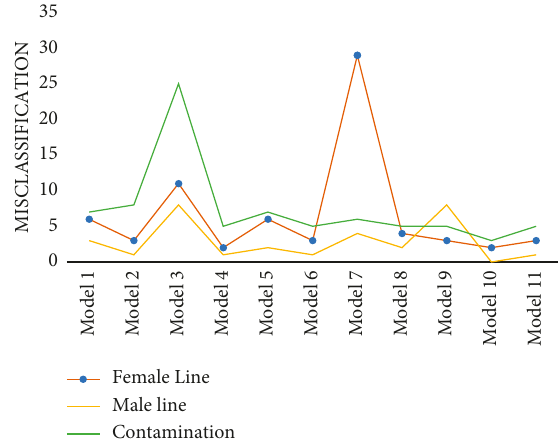
Figure 10: Plot of misclassification instances associated with the evaluation